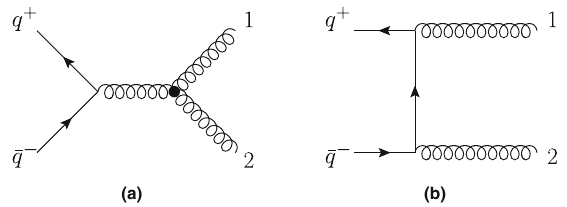
Fig. 2 The two diagrams contributing to the partial helicity amplitude M ( 0 → q + 12 ¯ q − ) , multiplying the color factor t 1